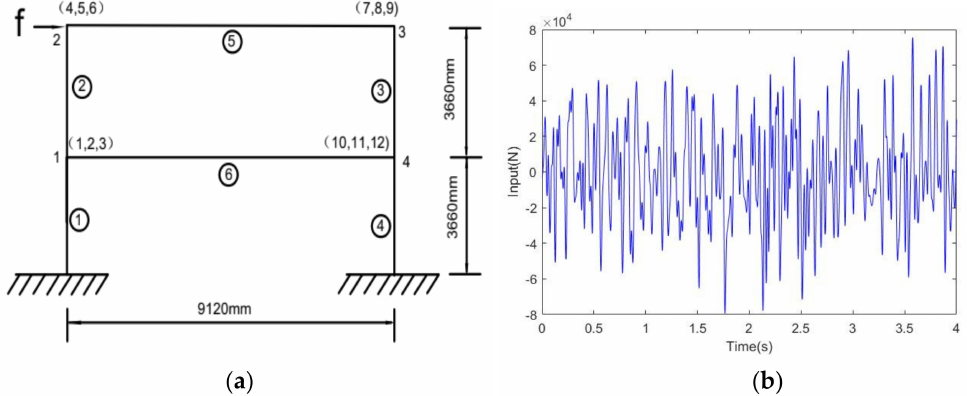
Figure 4. A plane frame subjected to stationary filtered white noise excitation. ( a ) A plane frame subjected to external excitation; ( b ) filtered white noise excitation generated according to the Kanai– Tajimi power